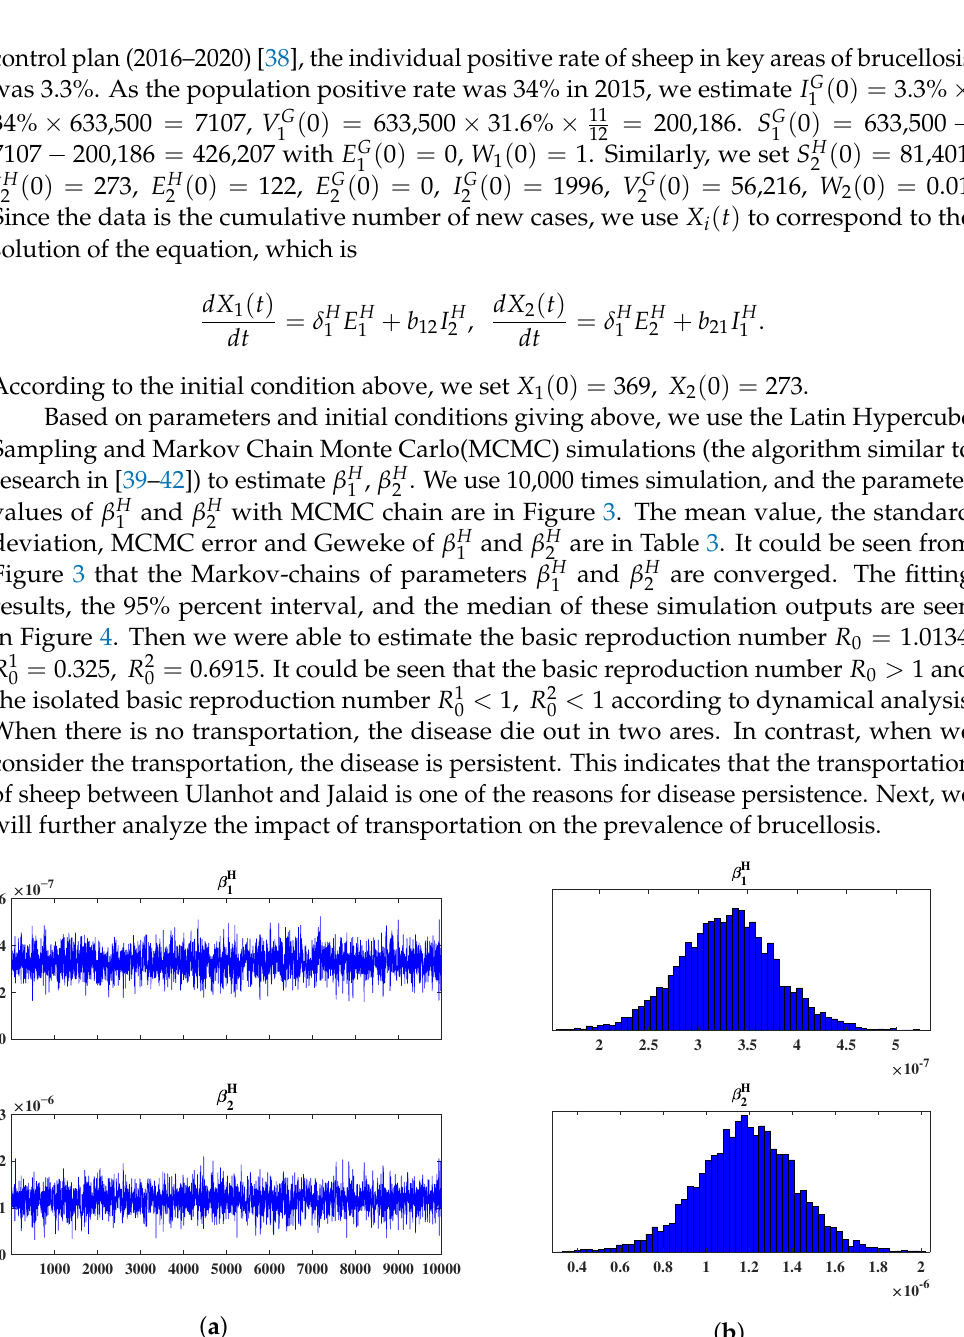
and β H of Markov chain with 10,000 sample 2 1 and β H . 2 1